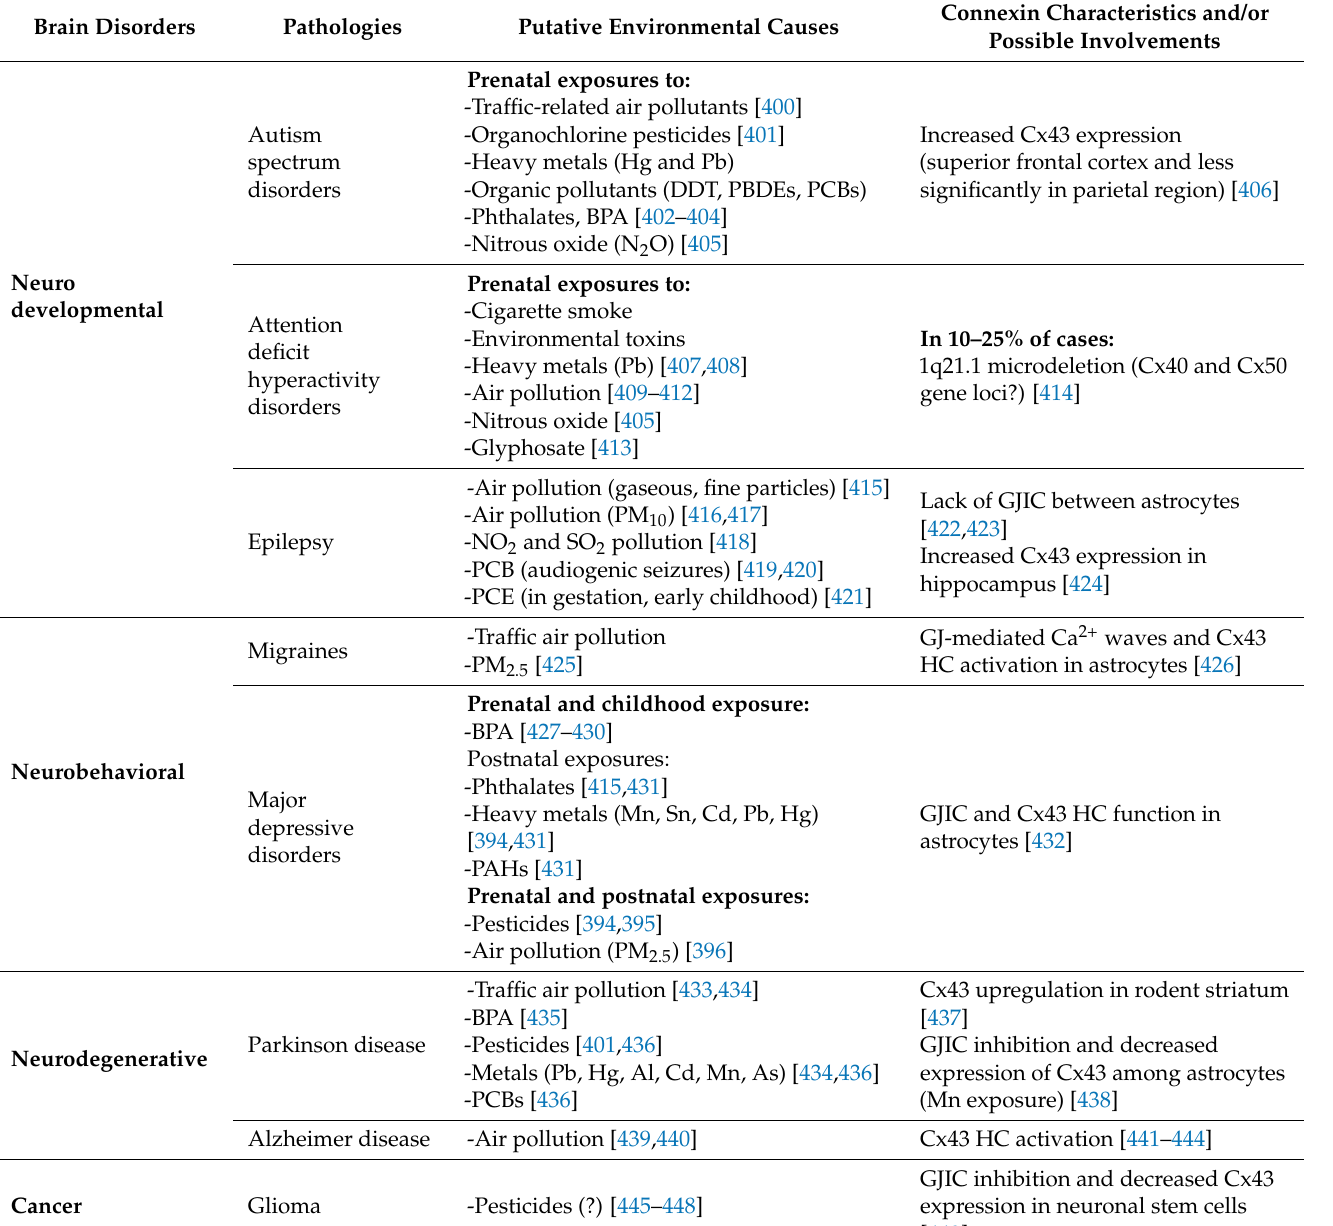
Table 4. Major brain disorders. Putative environmental causes and connexin characteristics/involvements. References are indicated between